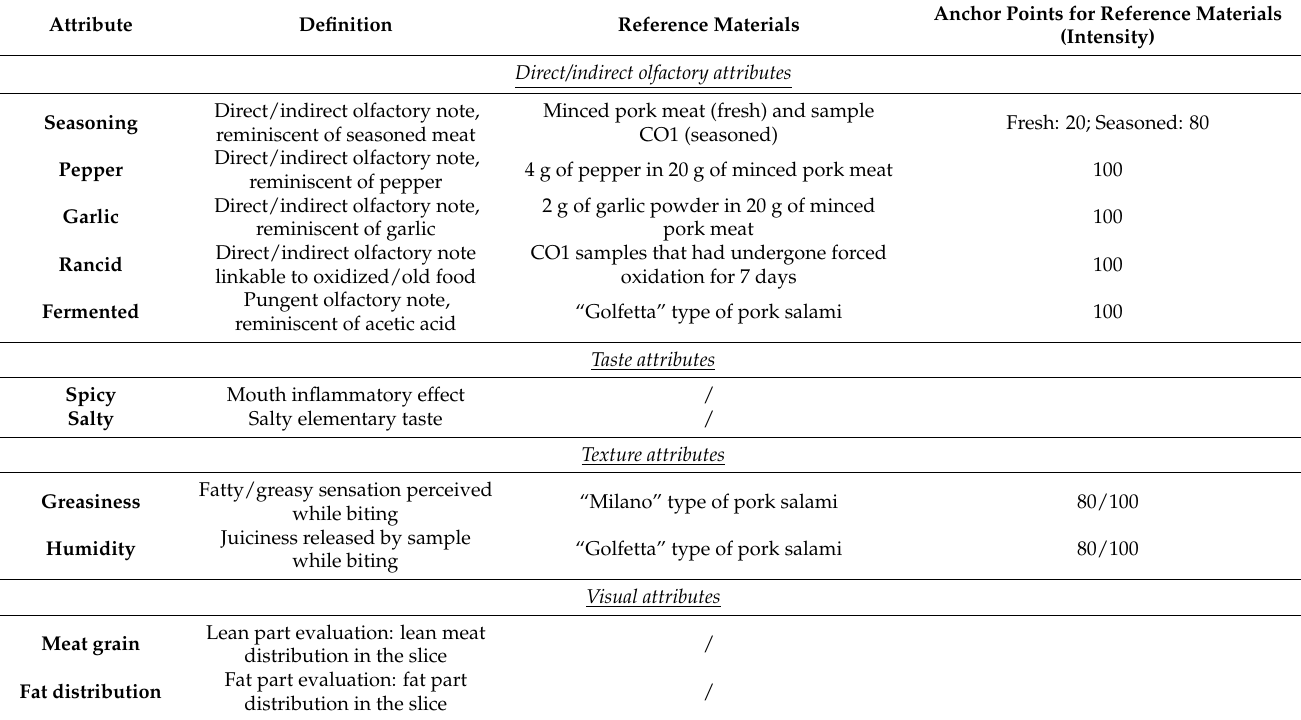
Table 2. Attributes used in the profile sheet for salami samples and their definitions, with anchor points and references used during the training